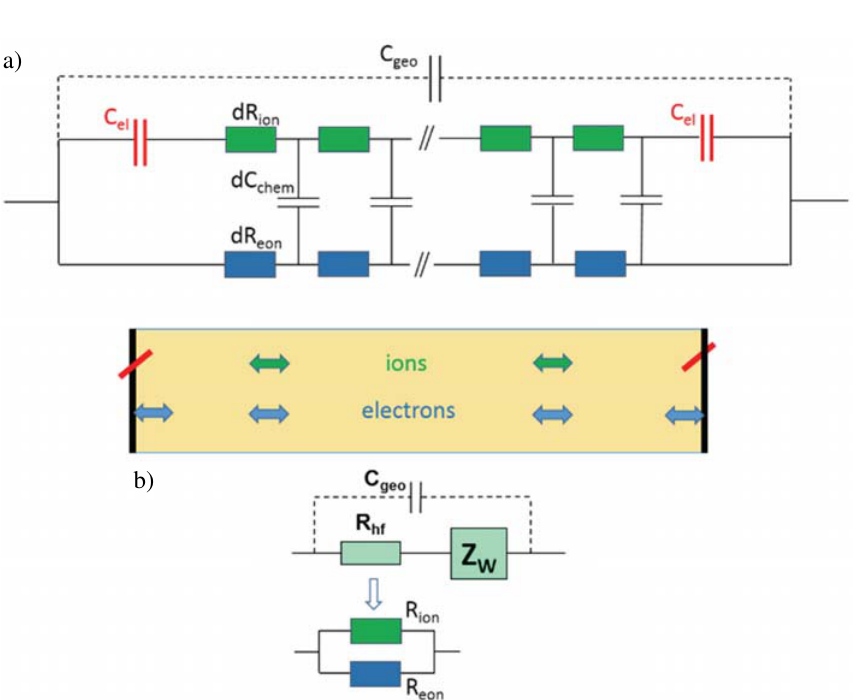
Fig. 6. (a) Equivalent circuit of a mixed conductor (cf. Fig. 2a) with terminals representing ideal ion blocking electrodes with negligible electronic contact resistance, the corresponding situation is sketched beneath. Here, the parallel dielectric displacement current via the geometrical sample ca- pacitance C is also taken into account. (b) Simplified equivalent circuit valid for C geo serial elements (R and Z ) correctly represent the analytical expression of the impedance but are not serial in real hf W